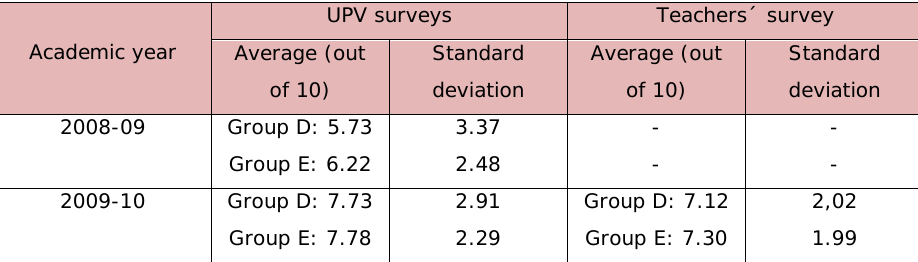
Table 7. “Assessment of motivation”. Source: